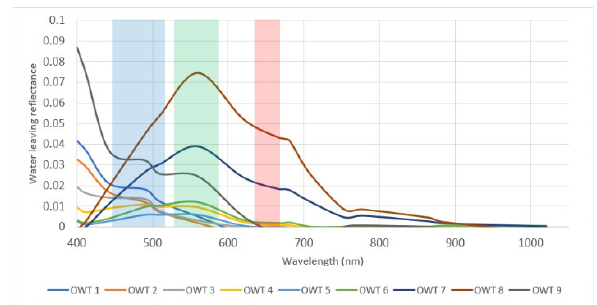
Figure 2. Spectral curves of sample pixels for each OWT